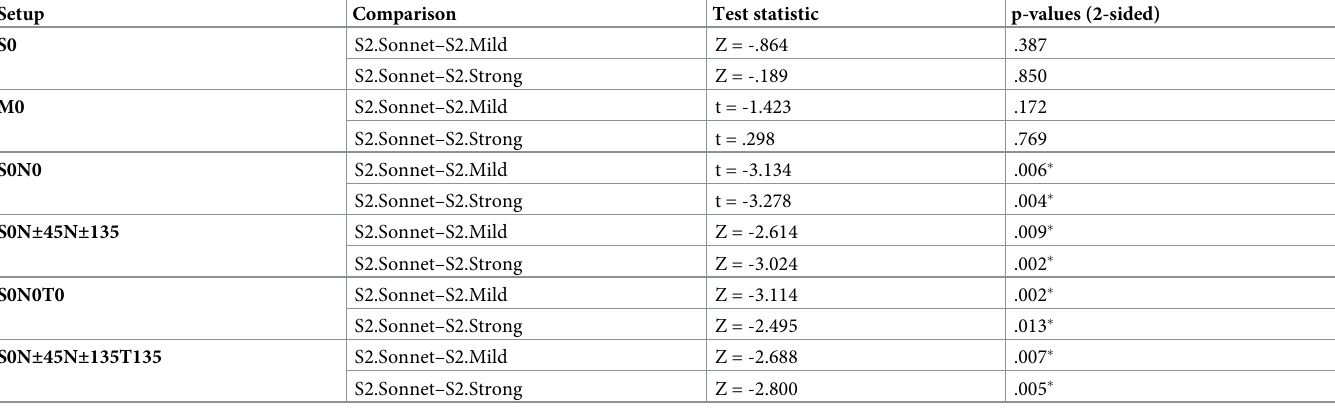
Table 6. Paired comparisons for subjects’ preference ratings between the S2.Sonnet and the SONNET 2 configurations S2.Mild or S2.Strong (original p-values).